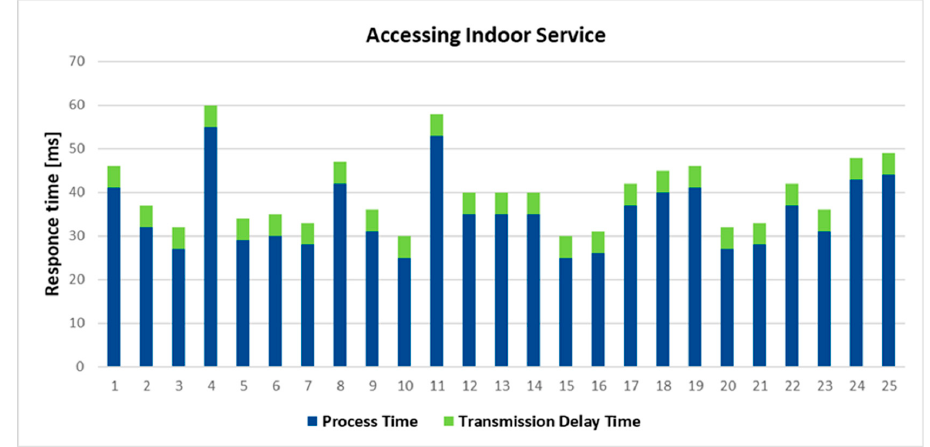
Figure 17. IP address response time for a different simultaneous request.